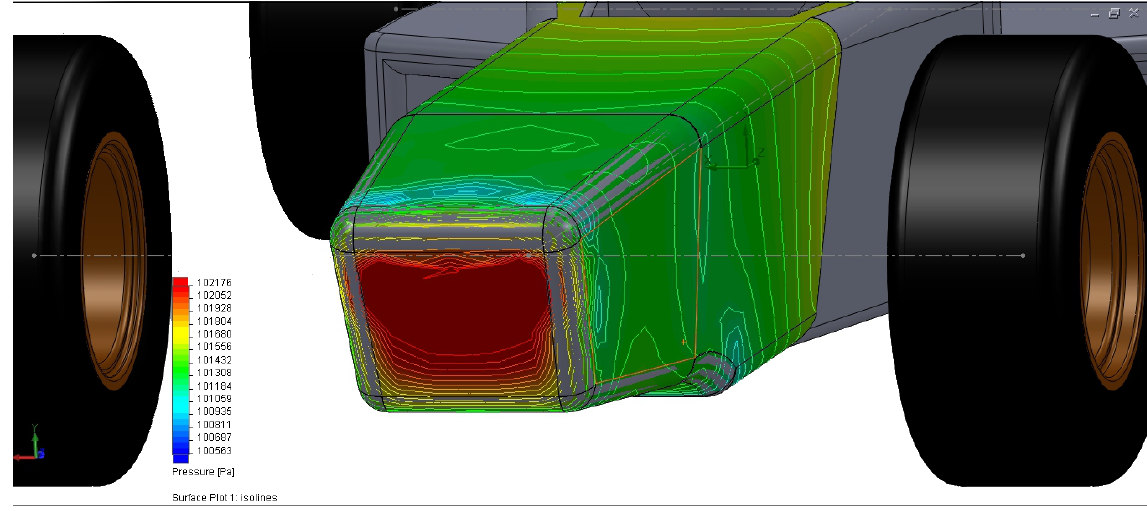
Figure 7. Air flow pressure distribution on prototype nose body (front view).